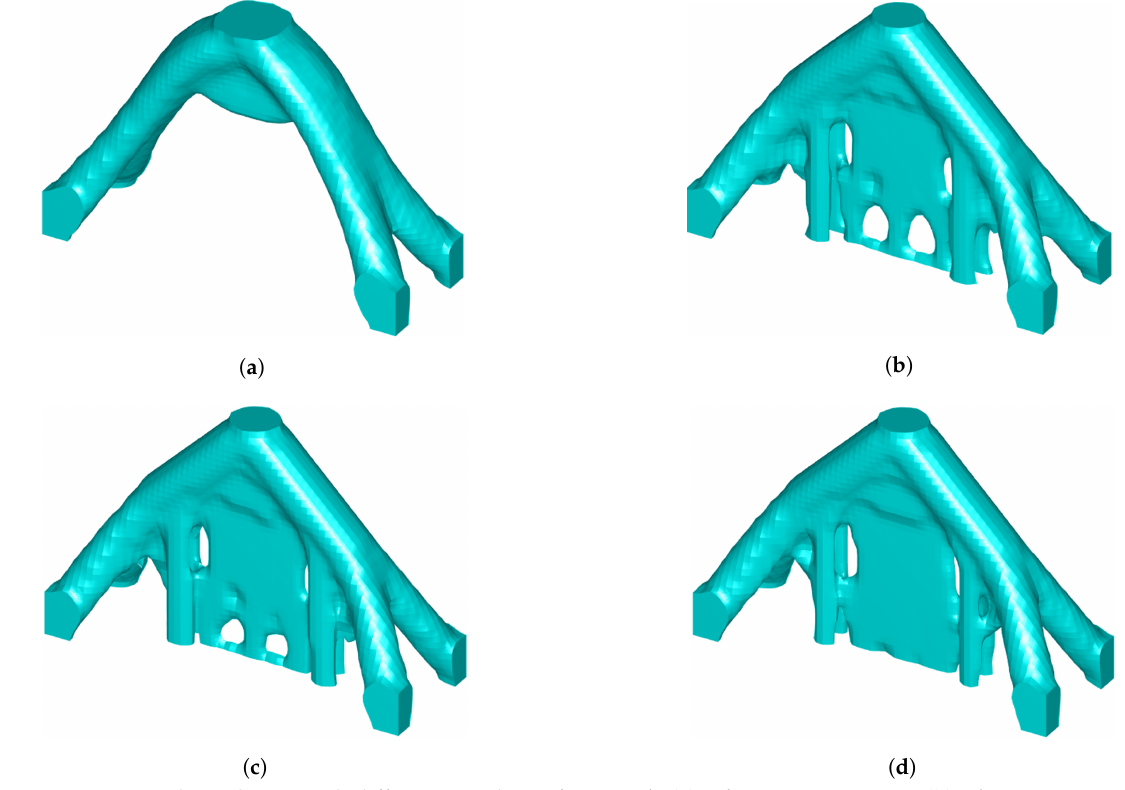
Figure 6. Optimized topologies with different weighting factors w ∗ : ( a ) reference, C = 3.621 J. ( b ) w ∗ = 1.01, C = 3.665 J. ( c ) w ∗ = 1.015, C = 3.662 J. ( d ) w ∗ = 1.02, C = 3.659